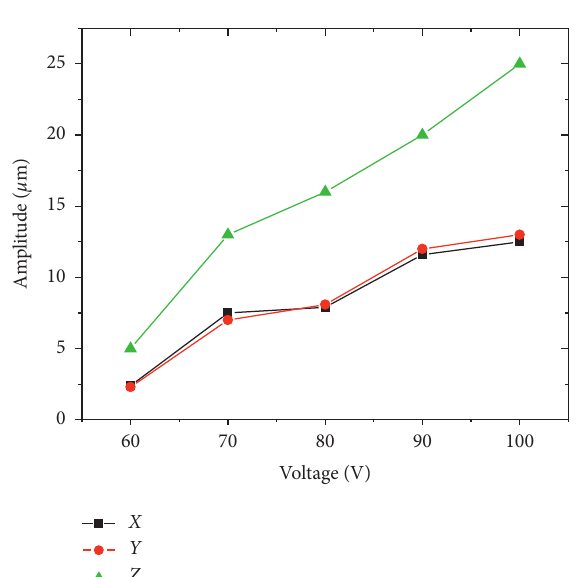
Figure 19: The relation between the output amplitude and input